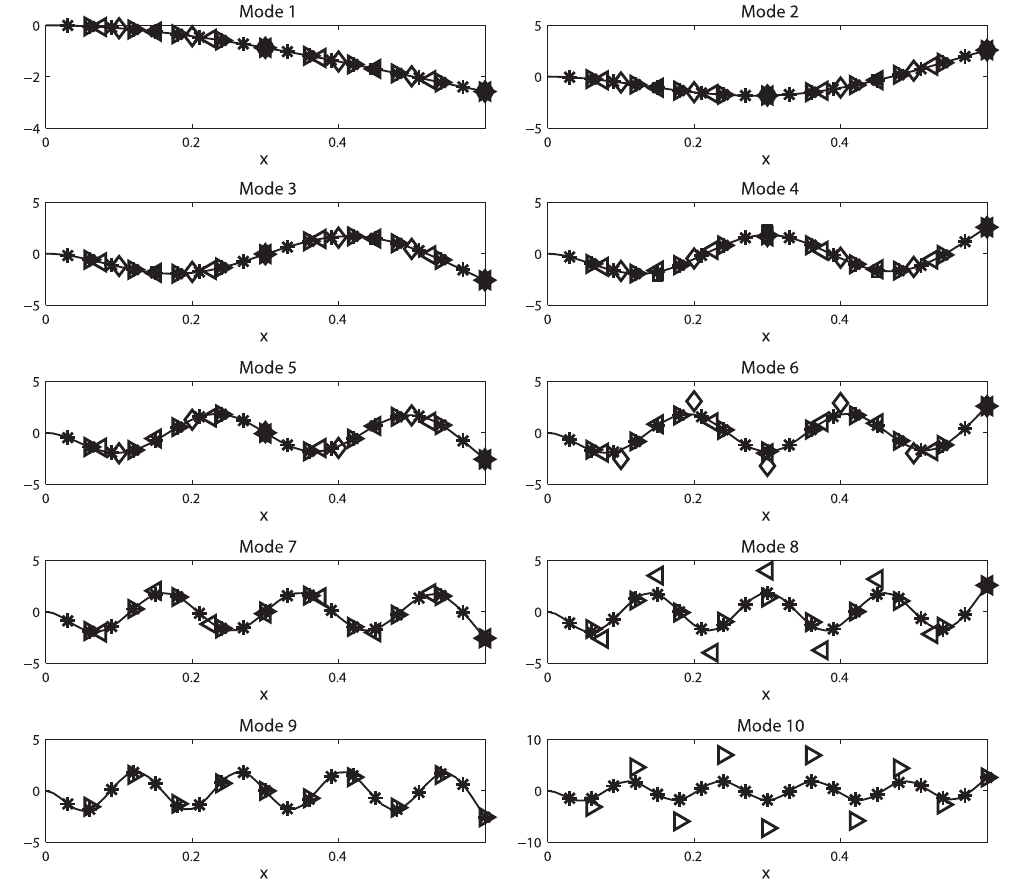
Fig. 1. The modal functions (solid line) and the modal functions approximated from the SD approach with N s = 2 ( ◦ ), N s = 4 ( (cid:4) ), N s = 6 ( (cid:5) ), N s = 8 ( (cid:3) ), N s = 10 ( (cid:4) ) and N s = 20 ( ∗